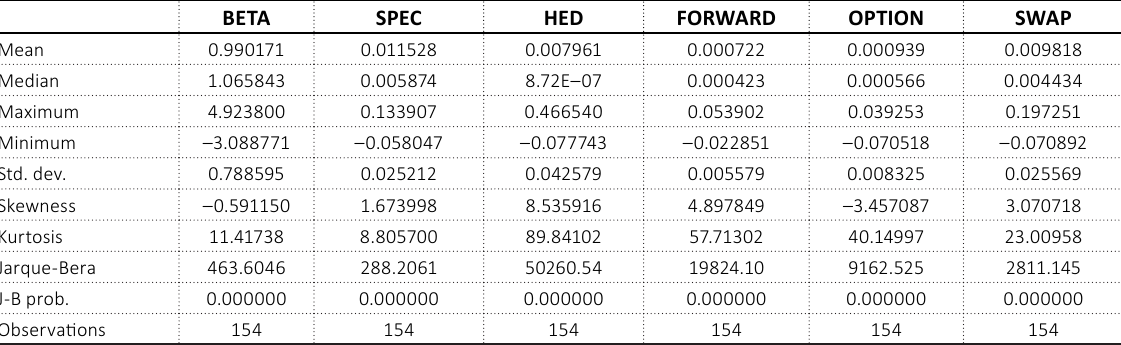
Table 4. Descriptive